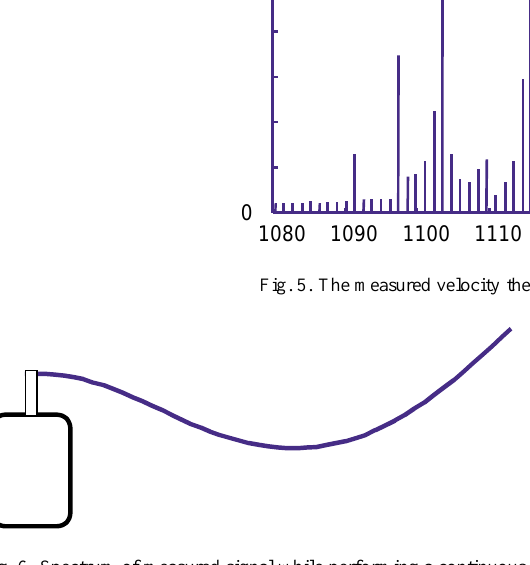
Fig. 6. Spectrum of measured signal while performing a continuous scan. Top left: broad frequency range, main figure: zoom around the excitation frequency.